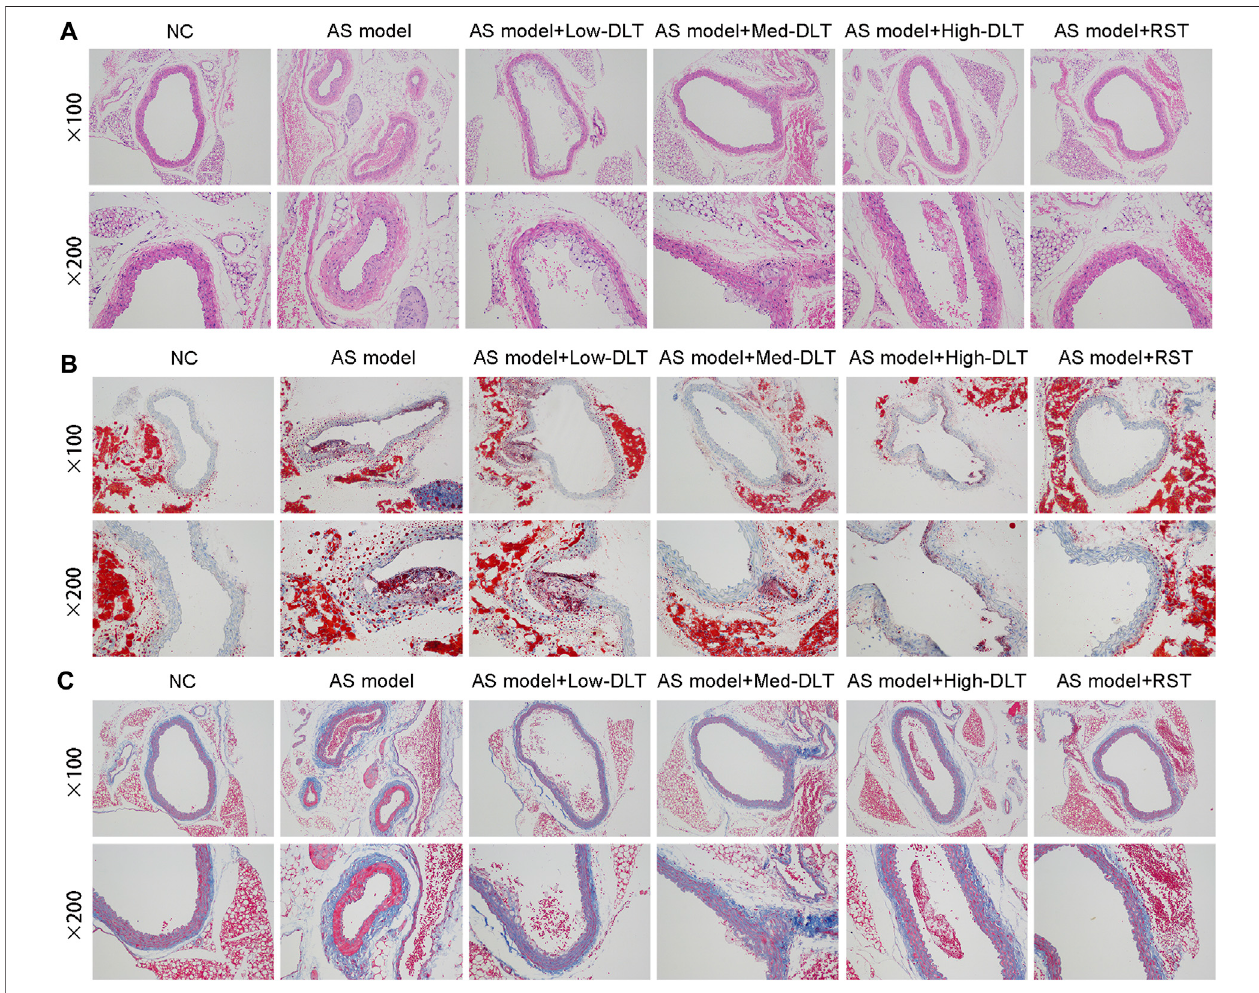
FIGURE 1 | Danlou tablets relieve the pathological lesion of AS in the ApoE − / − mice model. (A) Representative photomicrographs of hematoxylin eosin-stained aortic sinuses. (B) Representative photomicrographs of Oil red O-stained aortic sinuses. (C) Masson trichrome staining to show the fi brosis in different groups.